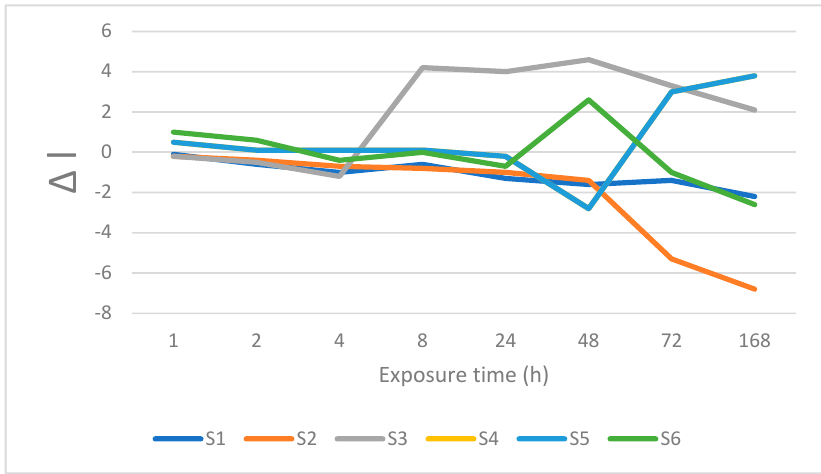
Figure 8. Changes is lightness after immersion in currant juice.